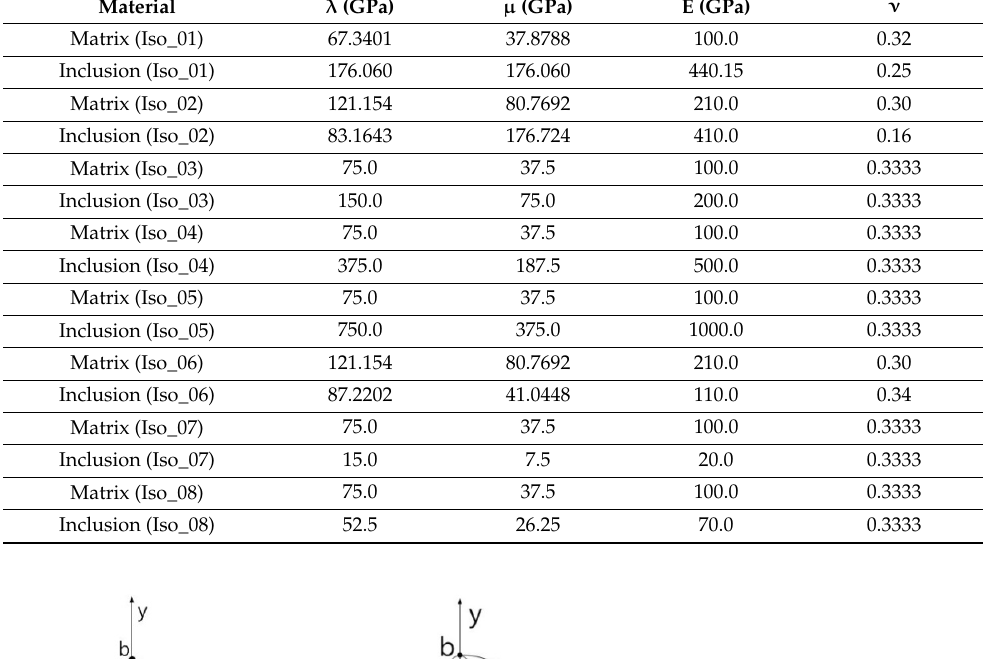
Figure 5. The orientation of spherical, prolate spheroidal and oblate spheroidal inclusions. ( a ) Sphe- roidal coordinate system. ( b ) Cartesian coordinate system. Figure 4. ( a ) Spherical, ( b ) prolate spheroidal and ( c ) oblate spheroidal inclusions under uniform remote tensile loading The elastic constants for the isotropic matrix and the isotropic inclusions are listed in ( σ oxx ). Table 2. The elastic constants for the isotropic matrix and the orthotropic inclusions are listed in Table 3. Table 2. Material Properties of the Isotropic Matrix and the Isotropic Inclusions. Material